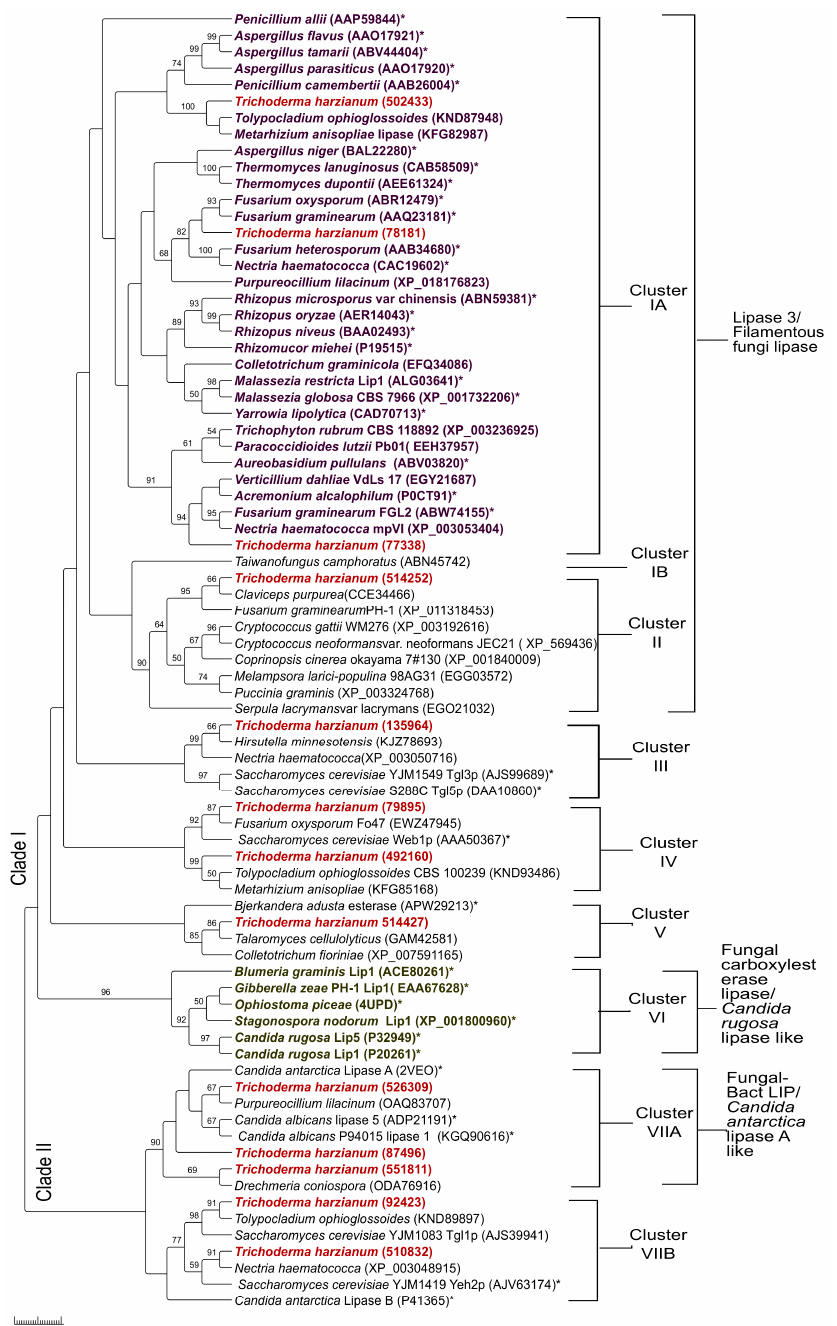
Figure 2. Phylogenetic tree of fungal lipases. The tree was constructed with 35 characterized fungal lipases (accessions correspond to GenBank unless another source is specified) and 15 putative triacylglycerol lipases from T. harzianum . (*) after the accession numbers are lipases which have been characterized; unlabeled proteins correspond to hypothetical, uncharacterized, predicted lipases. The tree was generated by MAFFT software using the neighbor-joining method [55] with 500 bootstrap re-samplings. Clusters IA, IB and II as described by Yadav et al. [6]. Highlighted in purple letters, the Rhizomocur miehei lipase-like group and in olive green letters, the Candida rugosa lipase-like group, according Schmidt-Dannert [44]. Clade I and Clade II, are consistent with Gupta et al. [76]. T. harzianum triacylglycerol lipases from this study, highlighted in bold red letters.